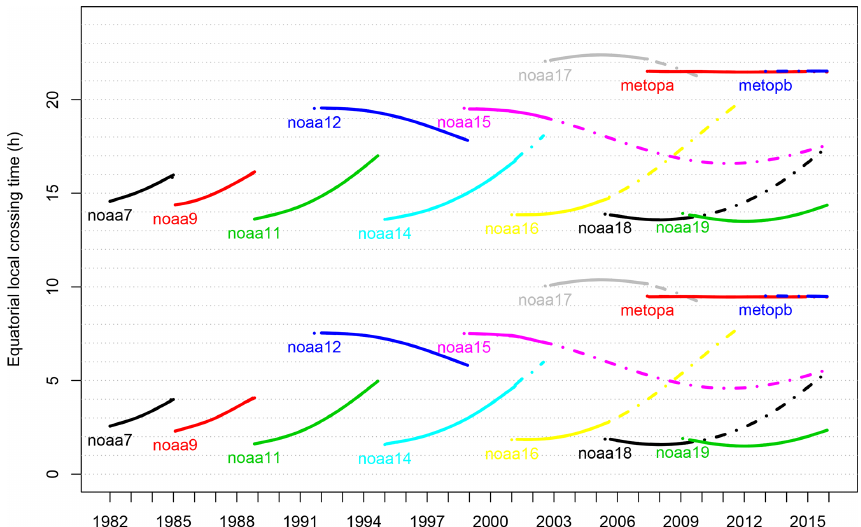
Figure 1. Time series of equatorial crossing time of the NOAA and MetOp satellites. Two observations per time per satellite are related to two satellite nodes (ascending and descending). The dot-dashed lines indicate data which are included in the CLARA-A2 dataset but excluded in other CFC CDR (e.g. the Cloud_cci dataset) due to an overlap with other satellites. This exemplifies one source of spurious trends in satellite CDRs caused by different data aggregation